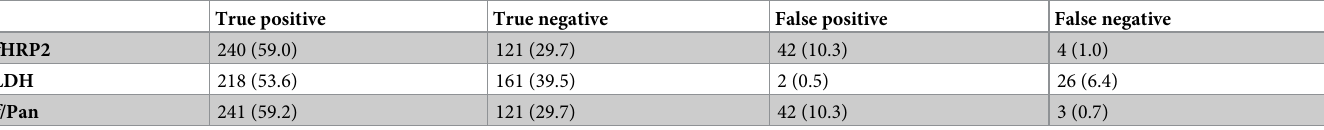
Table 2. Diagnostic performance of Pf HRP2, p LDH and Pf /Pan compared with expert microscopy (gold standard) for the diagnosis of Plasmodium falciparum malaria. True positive